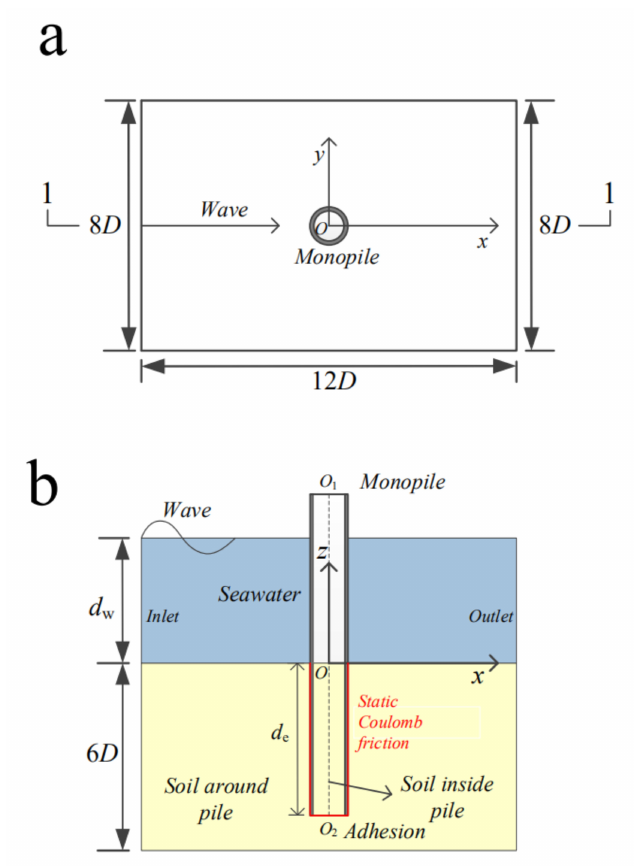
Figure 1. Wave-monopile-soil model used in this paper. ( a ) Plane view and ( b ) Cross Section